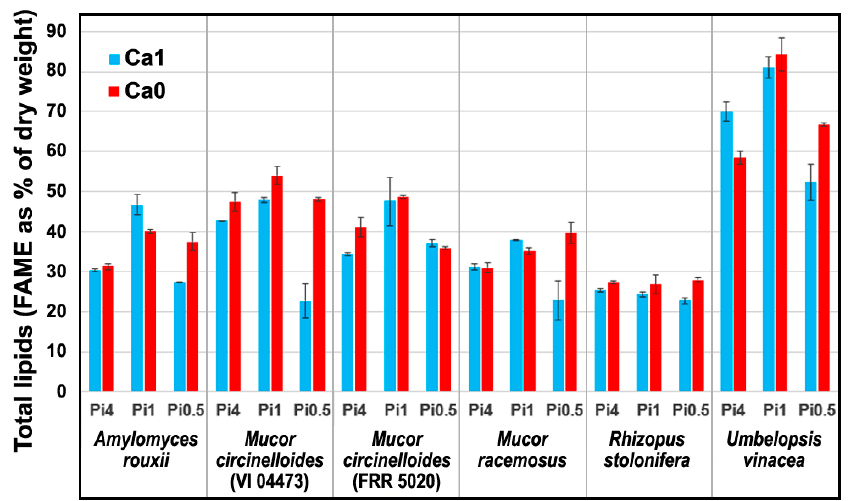
Figure 1. Total lipids content of the fungal samples grown under six different conditions (average values and range based on measurements of two biological replicates).